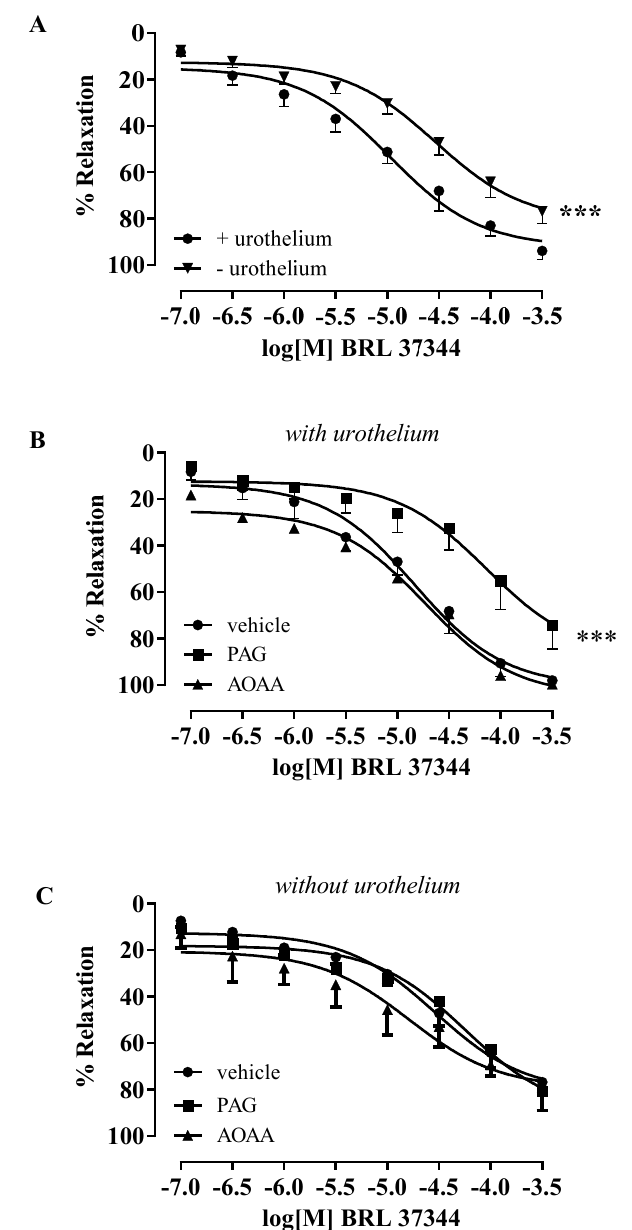
Figure 2. Effect of BRL 37344 on isolated human bladder strips. ( A ) BRL 37344 relaxed human bladder strips in a concentration-dependent manner. The relaxant effect of BRL 37344 was significantly higher in strips with intact urothelium compared to denuded strips (*** p < 0.001). ( B ) The relaxant effect of BRL 37344 was significantly reduced by PAG in strips with intact urothelium (*** p < 0.001). AOAA did not modify the relaxant effect of BRL 37344. ( C ) The relaxant effect of BRL 37344 was not affected by AOAA or PAG in denuded strips.